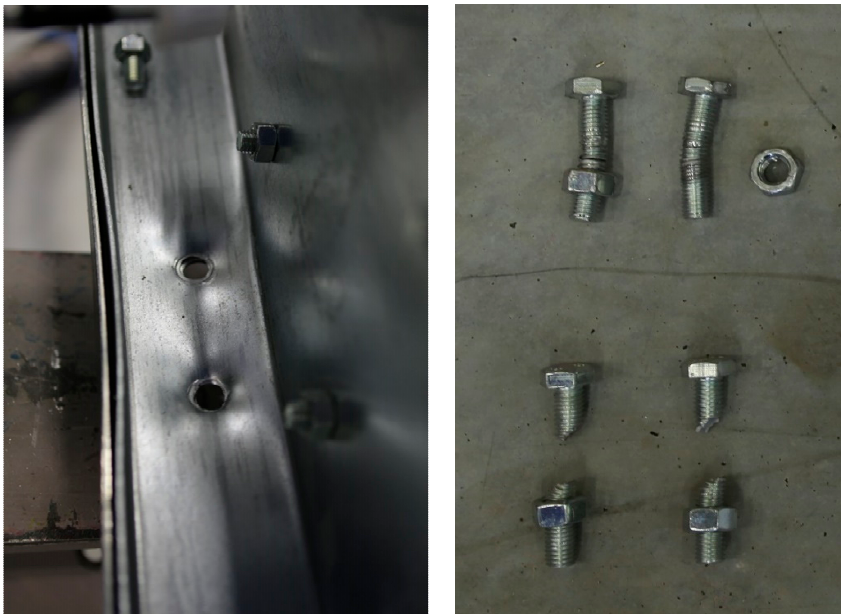
Figure 9. Photograph of the broken bolts.